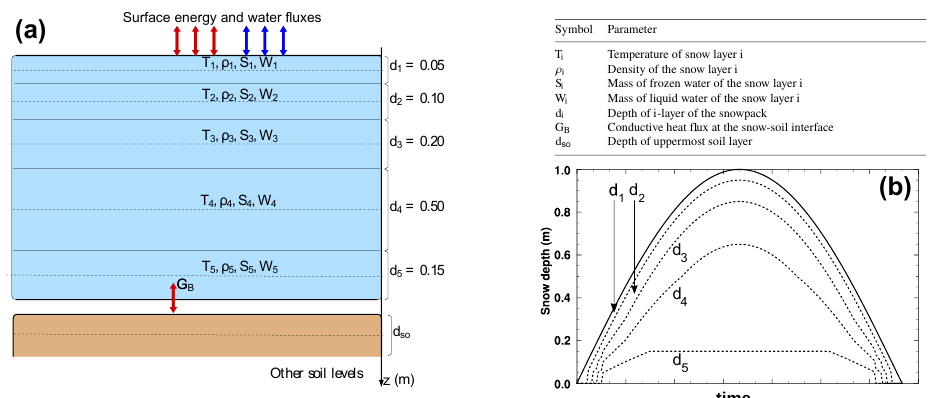
Figure 5. Schematic of the multi-layer snow scheme ( a ) for a 1-metre thick snowpack with its vertical discretization ( d 1 , . . . , d 5 , in m) for flat terrains. ( b ) Idealized time-series of snow depth accumulation and ablation (continuous line) over flat terrain, with the vertical discretization used in the multi-layer scheme. The list of symbols used in ( a , b ) is also